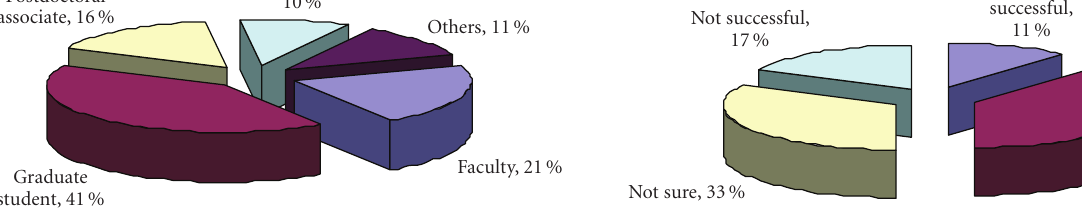
Figure 2: MFIX user categories.